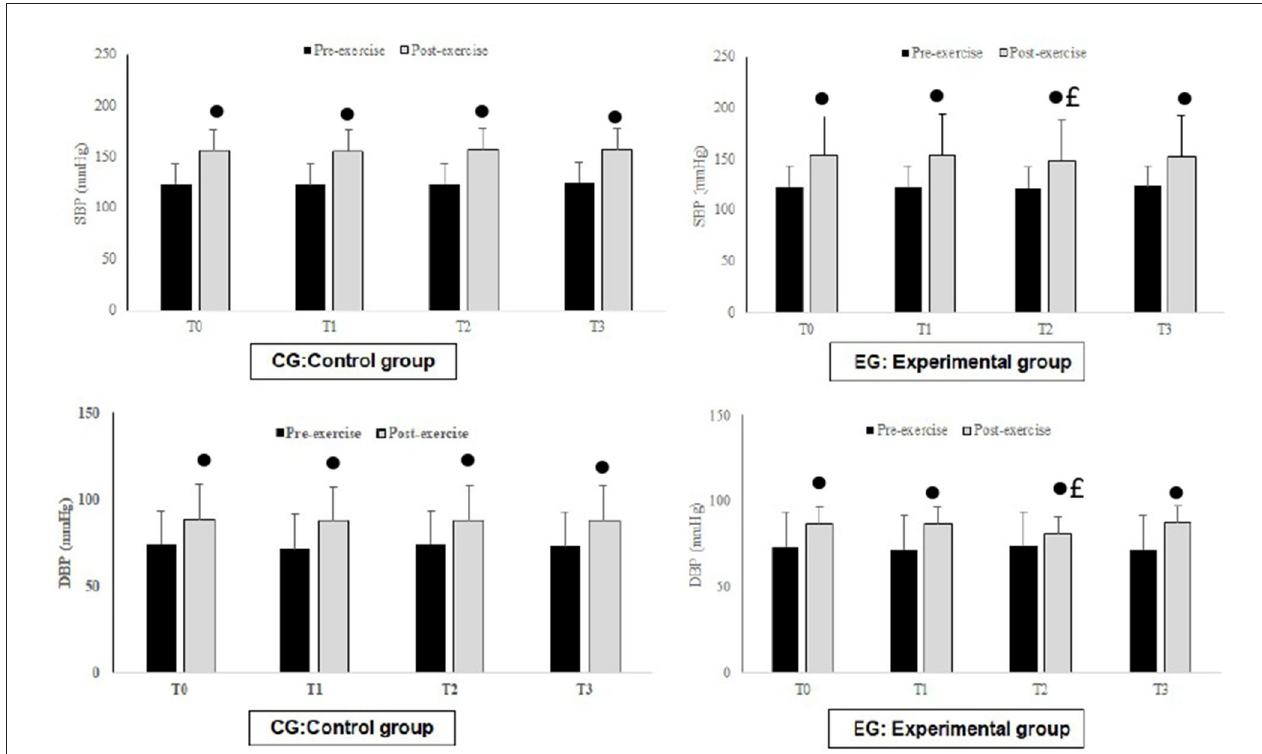
FIGURE 5 | Mean values ± standard deviation (SD) for systolic blood pressure (SBP) and diastolic blood pressure (DBP) value registered at rest and after exercise before Ramadan (T0), in the second week of Ramadan (T1), in the fourth week of Ramadan (T2) and after Ramadan (T3) in CG ( n = 12) and EG ( n = 12). •, Significant difference compared to T2; £, Significant difference compared to CG.